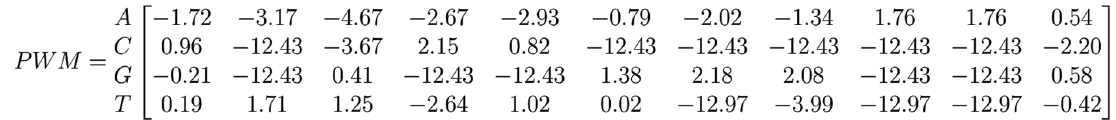
Figure 1. The STAT3 Jaspar matrix logo. The logo of the matrix STAT3 from the Jaspar database on which experiments have been done.